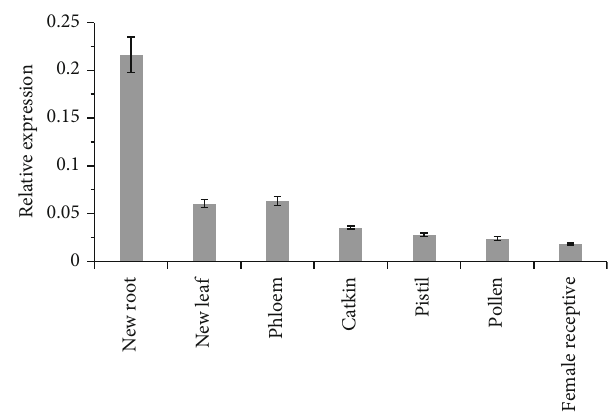
Figure 4: qRT-PCR analysis of SpuSKOR in di ff erent tissues/organs of purple osier. 1-year-old female purple osier plants were grown in 1/2MS liquid medium in a growth chamber with 12 h light at 25 ° C followed by 12 h dark at 20 ° C (with 60% relative humidity). Di ff erent tissues/organs were collected from the same plant